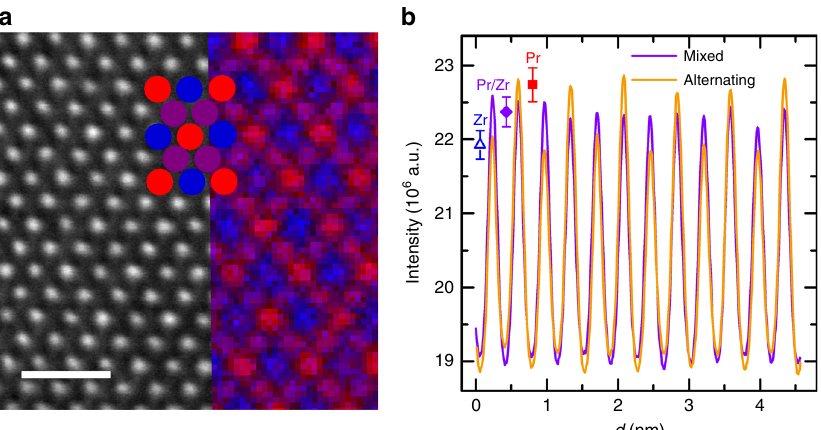
Fig. 5 Electron energy loss spectra for Pr 2 Zr 2 O 7 . a HAADF STEM of Pr 2 Zr 2 O 7 oriented down the [110] direction. Corresponding EELS map is shown on the right. Circles represent columns of Pr (red), Zr (blue), and mixed (purple). Scale bar represents a distance of 1.0 nm. b Averaged intensity pro fi les of PZO down the [110] direction with purple diamond, blue triangle, and red square representing average column intensity maxima for mixed columns, Zr columns, and Pr